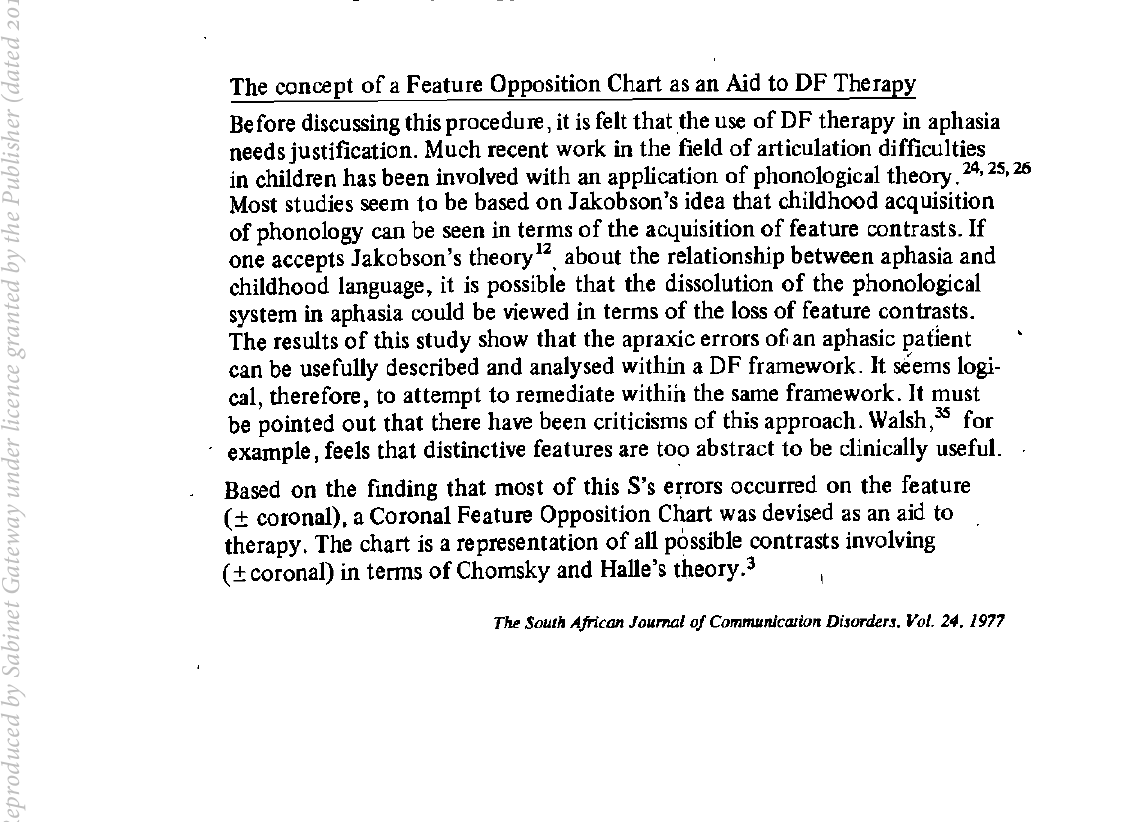
Figure 5: Analysis of self-correction